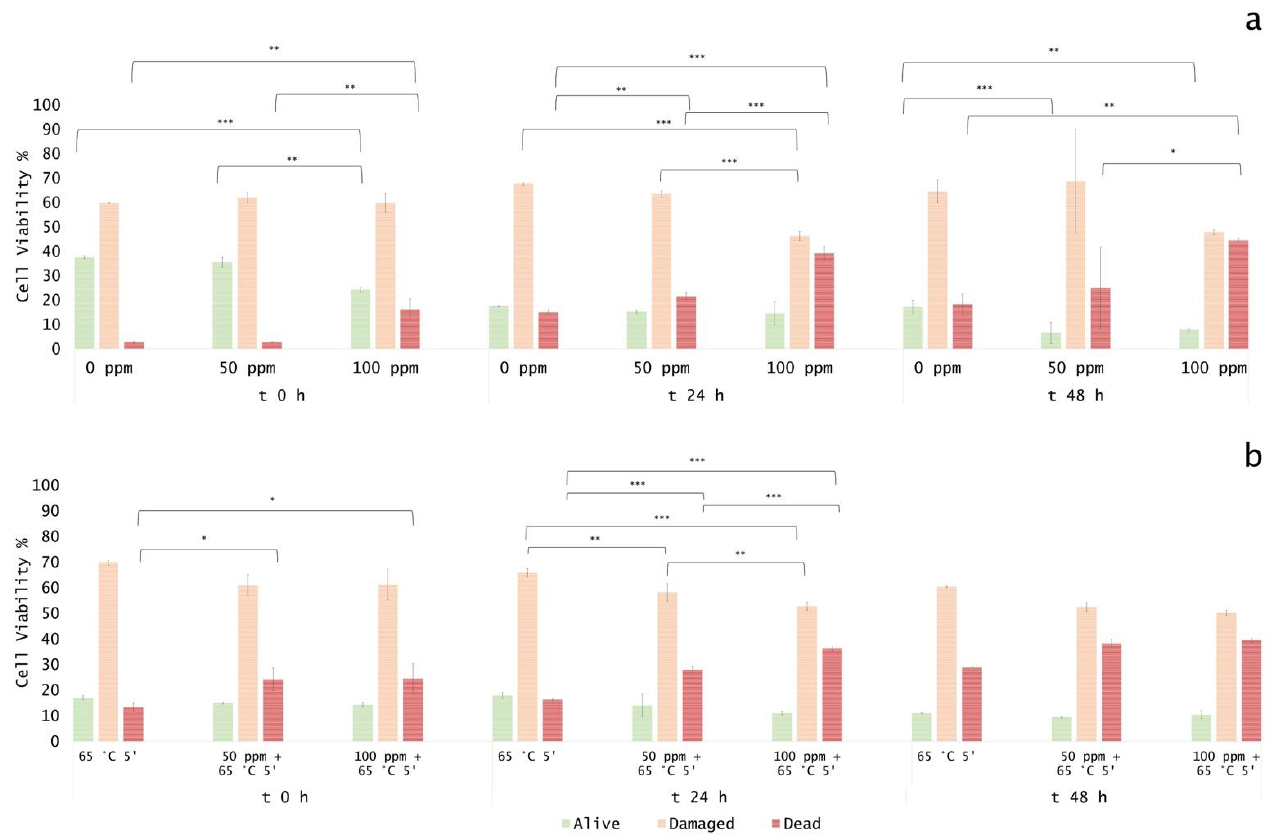
Figure 8. Percentage of alive, dead, and damaged cells concerning total FCM events (100%) in Fruit Juice (pH 3.8): ( a ) OEO treatment and ( b ) combined treatment at 65 ◦ C 5 min. The shown values correspond to the means and respective standard deviations of replicates, independently analyzed. p -value less than 0.05 is flagged with one star (*), less than 0.01 with 2 stars (**) and less than 0.001 with three stars (***).